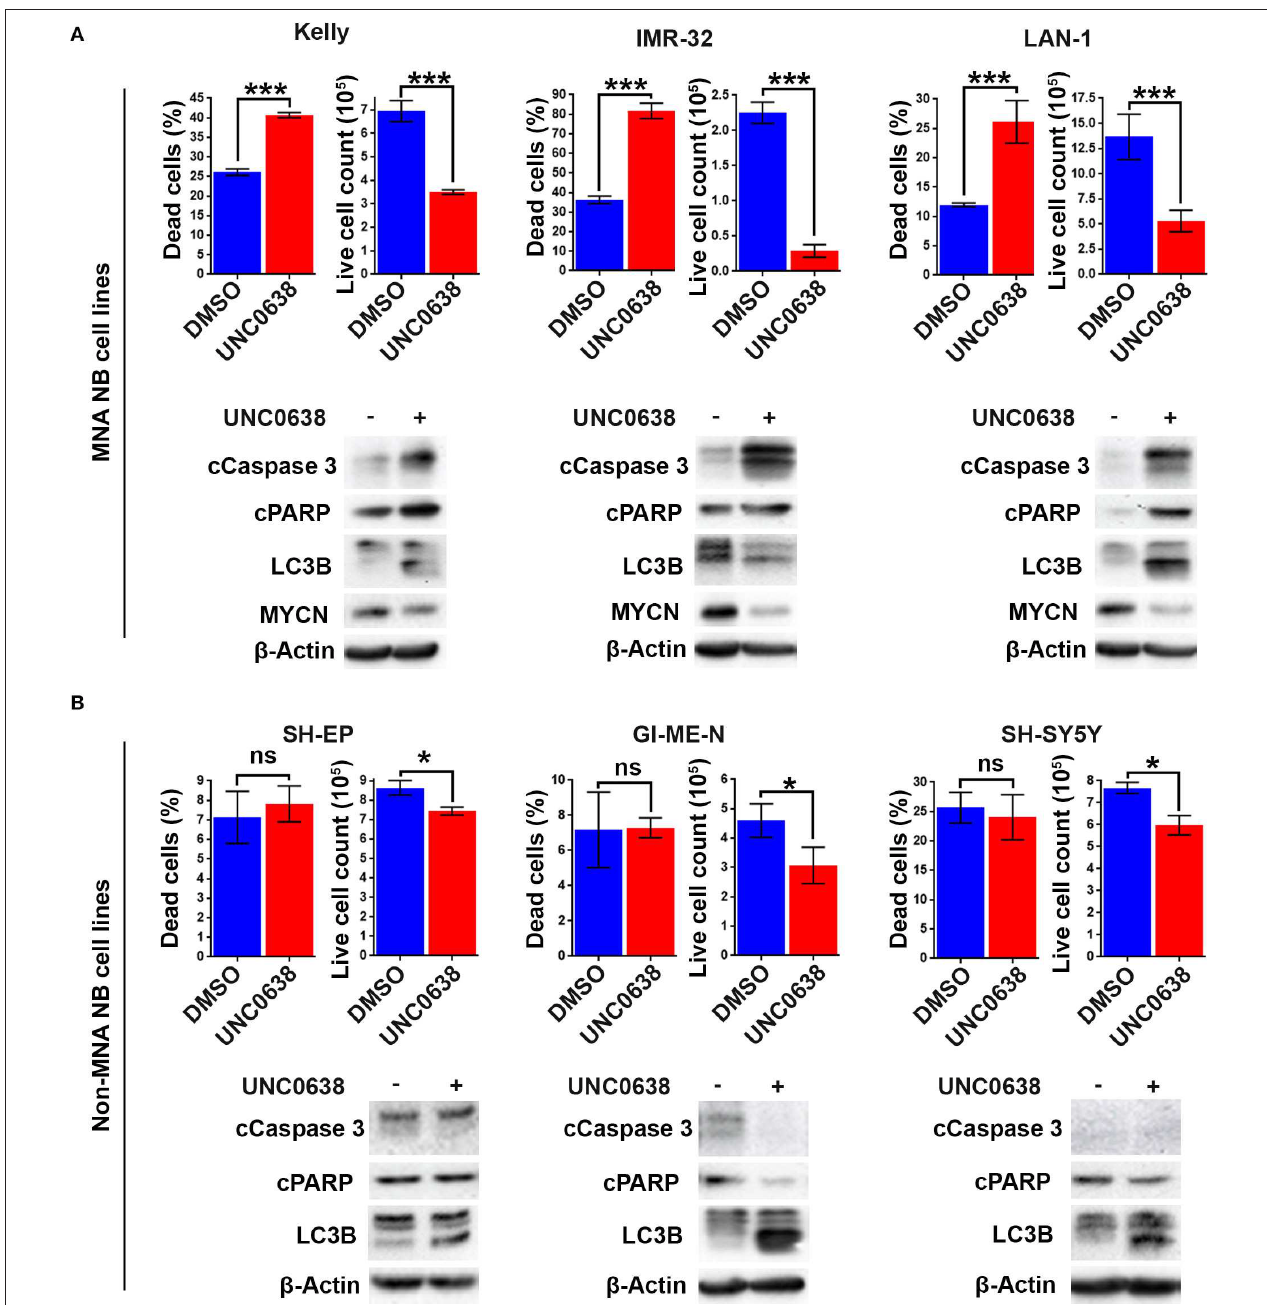
FIGURE 6 | UNC0638 specifically induces apoptosis in MNA neuroblastoma cell-lines. (A) Floating and adherent cells from MNA cell lines were harvested and counted by trypan blue inclusion assay following 5–10 µ M UNC0638 treatment for 72h. The left-hand graph of each cell line shows the percentage dead cells, while the righthand graph shows the live cell counts, which was used as a proxy for cell growth. Significant changes are indicated by asterisks (*** p < 0.01, n = 3). Error bars show the SEM. Western blots for each cell line show markers for cell death, autophagy markers and MYCN. β -Actin is used as loading control (representative of n = 3). (B) Live and dead cell counts and Western blots of non-MNA cells after treatment with 10 µ M UNC0638 for 72h (* p < 0.05, ns not significant, n = 3).